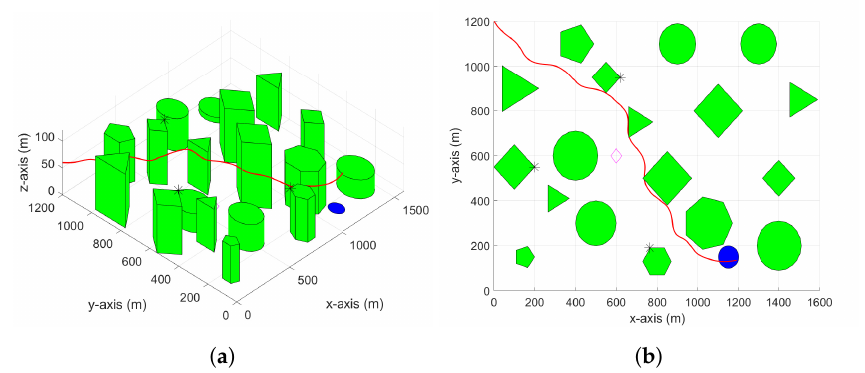
Figure 8. 3D ( a ) and 2D ( b ) views of the UAV trajectory by the proposed method in another urban environment.